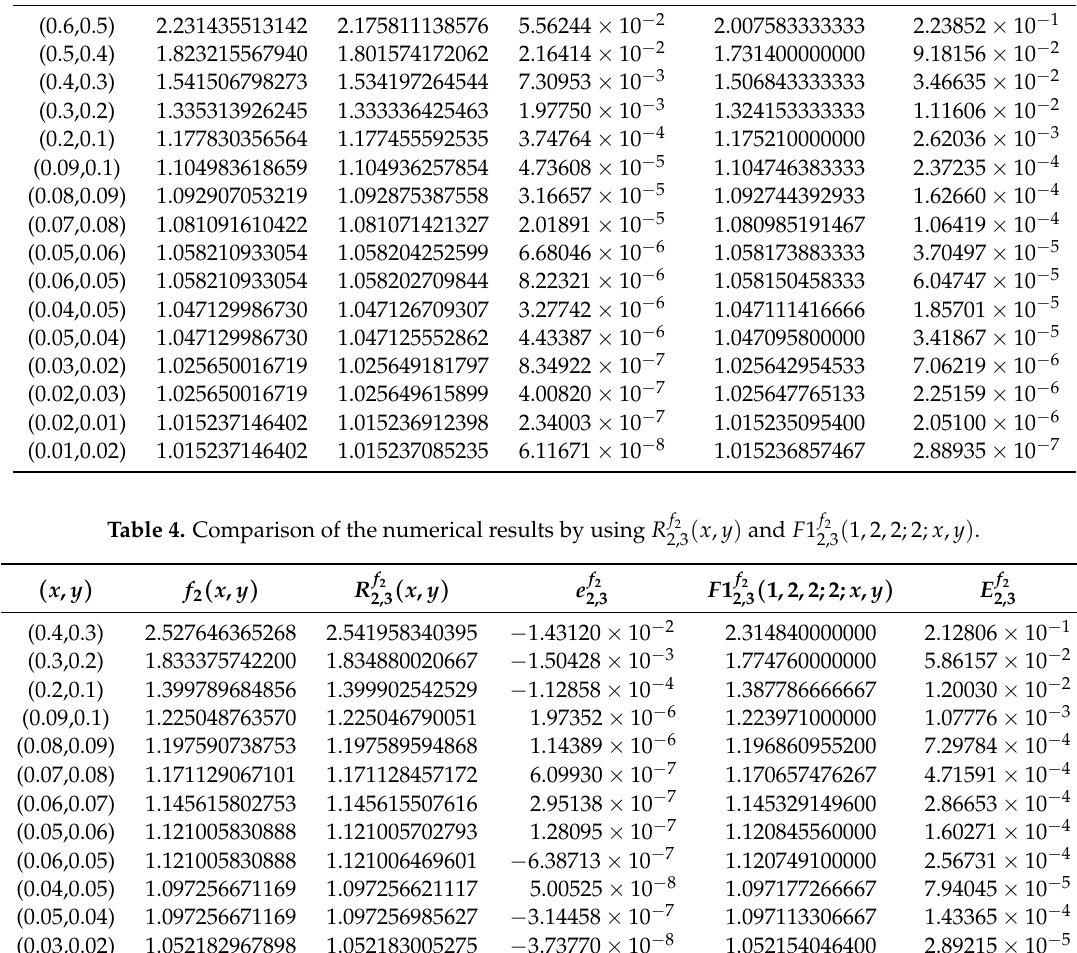
Table 3. Comparison of the numerical results by using R f 1